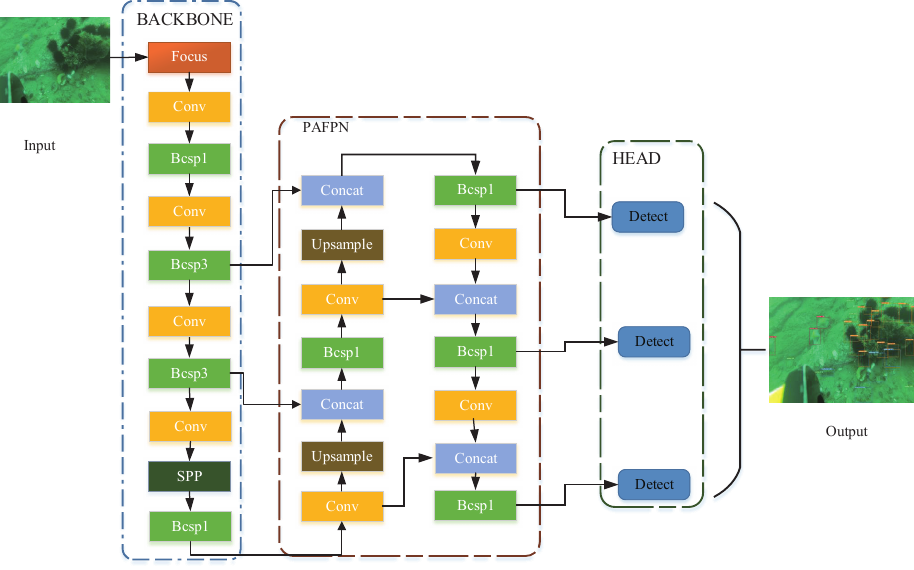
Figure 1. Network architecture of